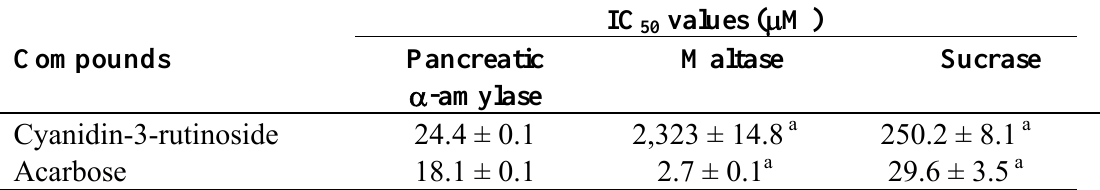
Table 2. The IC values for pancreatic α -amylase, intestinal α -glucosidase (maltase and 50 sucrase) by cyanidin-3-rutinoside and acarbose. Results are expressed as means ± S.E.M., n = 3. a The IC value of cyanidin-3- rutinoside was previously reported in 50 Adisakwattana et al.